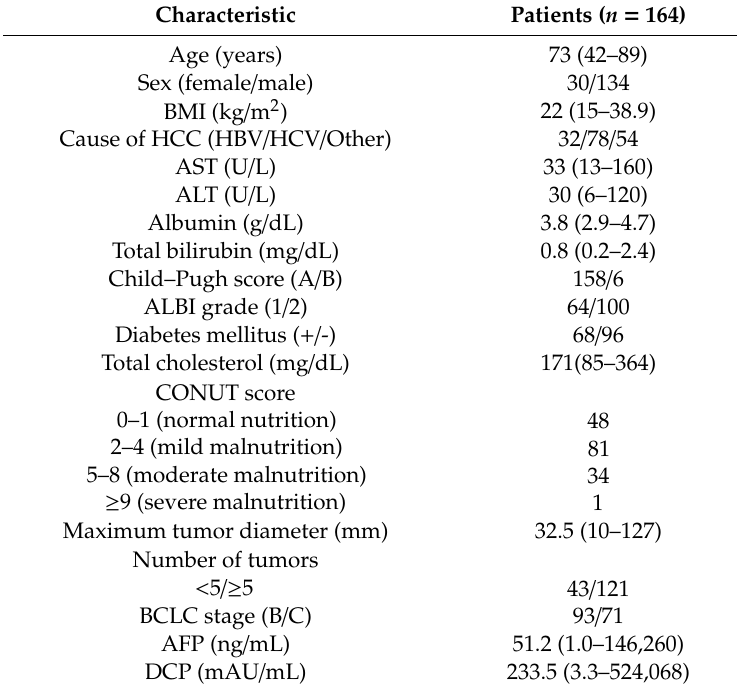
Table 1. Patient